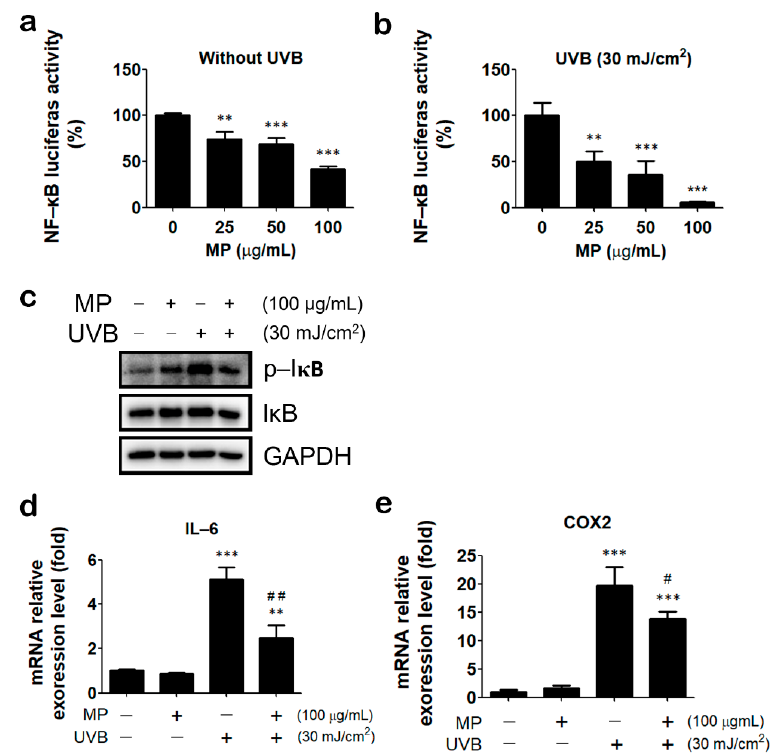
Figure 4. MP fraction alleviated UVB − induced activation of NF- κ B signaling. ( a ) MP fraction was incubated with HaCaT/KBR cells for 4 h and washed out for 4 h with reporter assay. ( b ) HaCaT/KBR cells were treated with MP fraction as described in ( a ) and followed by UVB irradiation and reporter assay. ( c ) HaCaT cells were pre-treated with MP fraction for 4 h and then washed out for 4 h. Then, cells were exposed to UVB and harvested for immunoblot. ( d , e ) HaCaT cells were pre-treated with MP fraction for 4 h and then washed out for 4 h before UVB exposure, and incubated in serum-free DMEM for 18 h, then cells were harvested for QPCR. Data are presented as mean ± SD from three independent experiments. The statistical significance was defined as ** p < 0.01 and *** p < 0.001 compared with solvent control cells; # p < 0.05, ## p < 0.0 compared with UVB-irradiated